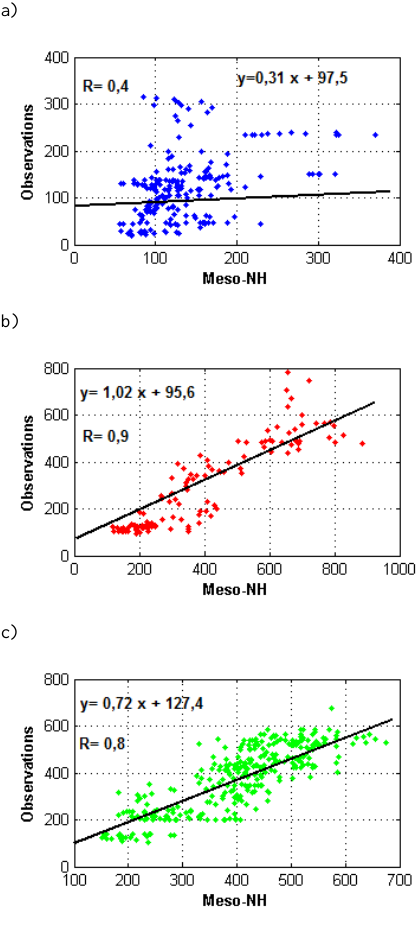
Figure 12. Scatterplot of the CCN evolution during the flight of the ATR-42 at (a) 0.5–0.9km, (b) 1–2.4km and (c) 2.5–3km on 30 May 2008 over the Netherlands between 52.57 ◦ N, 6.34 ◦ E and 51.88 ◦ N, 4.99 ◦